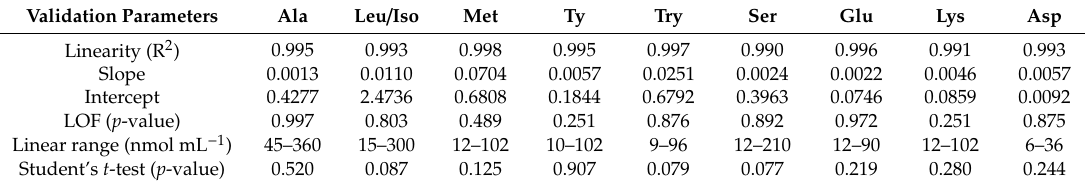
Table4. Analytical curves data, Student’s t -test, andlack-of-fit statistical test of thein-tube SPME-MS / MS method to determine AA and NT in plasma samples.